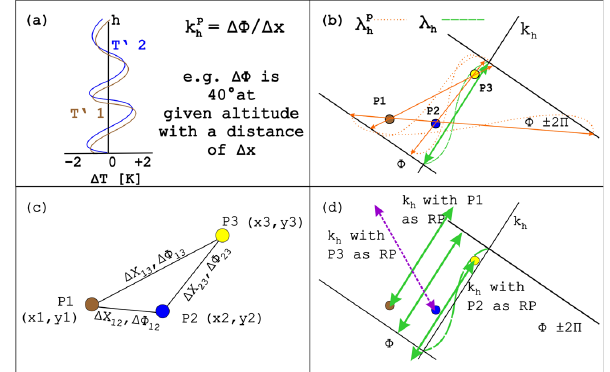
Fig. 1. Two RO temperature fluctuation ( T 0 ) profiles ( a ) and their corresponding horizontal wavelength ( λ v ) spectra ( b,c ). The cross- wavelet shows the phase shift at each altitude ( d ), for the dominant vertical wavelength ( λ v ).